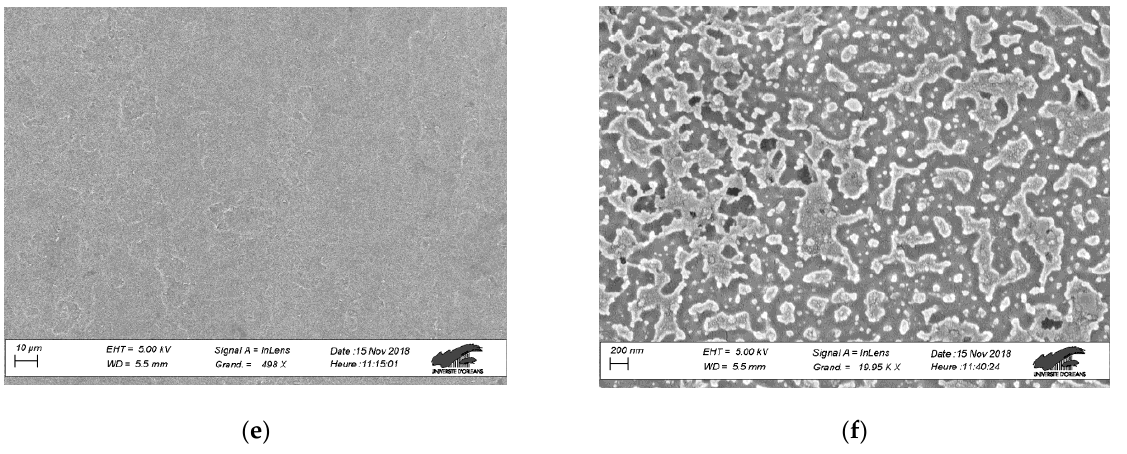
Figure 5. SEM images at different magnifications of untreated and plasma treated epoxy polymer surfaces with air DBD and Gliding Arc: ( a ) untreated—x500, ( b ) untreated—×20,000, ( c ) Gliding Arc—×500, ( d ) Gliding Arc—×20,000, ( e ) air DBD—×500, and ( f ) air DBD—×20,000.